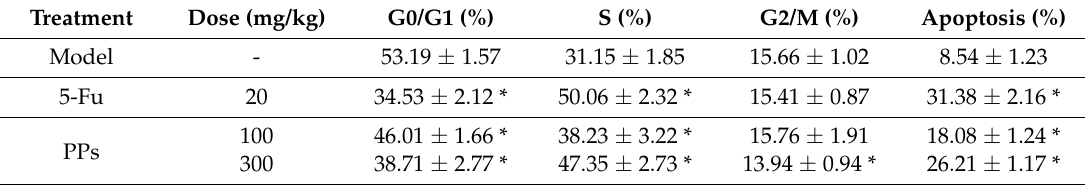
Figure 5. Effects of PPs on cell cycle phase distribution of S180 tumor cells in vivo. The blue, red-1, red-2 colored and shaded areas showed the percentages of cell numbers in apoptosis, G0/G1, G2/M, and S phase, respectively. Table 4. Effects of PPs on cell cycle phase distribution of S180 tumor cells in vivo.